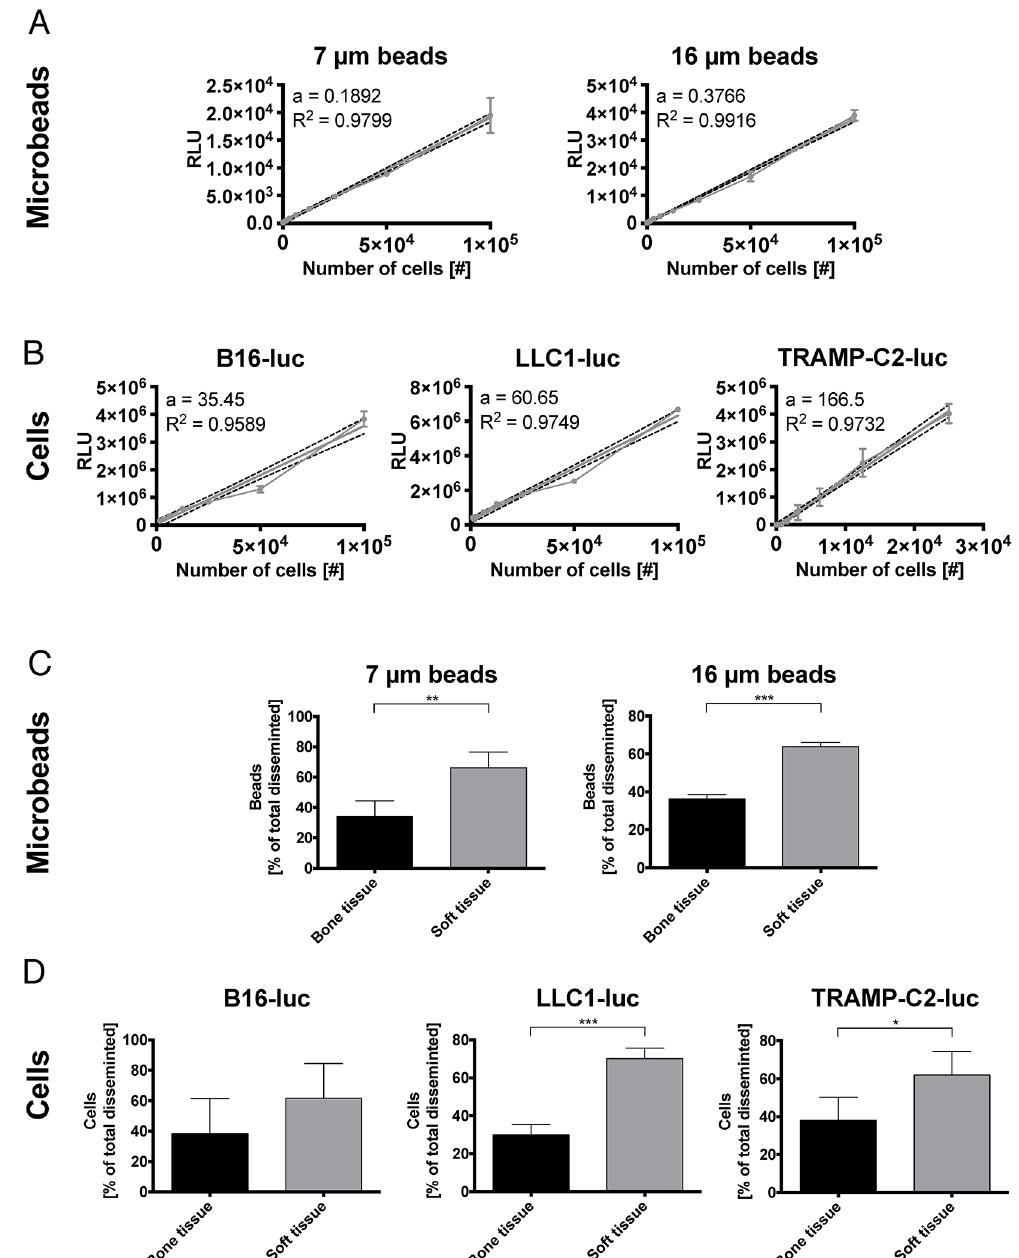
Fig 2. Number of cells and microbeads show linear correlation with their luminescence and fluorescence respectively and disseminate preferentially to soft tissue organs. (A) Standard curve of nucleus sized 7 μ m GFP microbeads (D, a: 0.1892 FI/cell R 2 : 0.9799) and cell sized 16 μ m GFP microbeads (E, a: 0.3766 FI/cell R 2 : 0.9916) links fluorescence intensity (FI) to the number of beads emitting the light. Mean ± SD, n = 3 for all experiments shown. (B) Standard curves of B16-luc (A, a: 35.95 RLU/cell, R 2 : 0.9589), LLC1-luc (B, a: 60.65 RLU/ cell R 2 : 0.9749) and TRAMP-C2-luc (C, a: 166.5 RLU/cell R 2 : 0.9732) show luciferase photon emission in relative light units (RLU) per number of cells. Mean ± SD, n = 3 for all experiments shown. (C) Comparison of general dissemination patterns between soft and osseous organs demonstrate significantly increased dissemination to soft tissues for microbeads independent of their size. Mean ± SD, (7 μ m beads n = 5, p = 0.0156, 16 μ m beads n = 5, p < 0.0001), for all experiments shown, Student ’ s t-test. (D) LLC1-luc and TRAMP-C2-luc showed increased soft tissue dissemination. Only B16-luc displayed a non-significant trend for increased dissemination to soft tissues. Mean ± SD, (B16-luc n = 4, p = 0.2032, LLC1-luc n = 5, p < 0.0001, TRAMP-C2-luc n = 5, p = 0.0150), for all experiments shown, Student ’ s